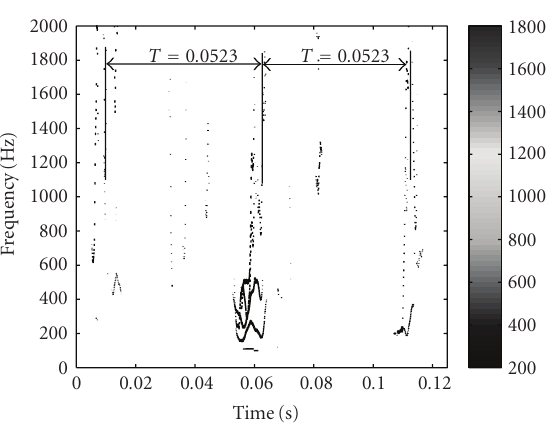
vibration signals were loaded into MATLAB from data-